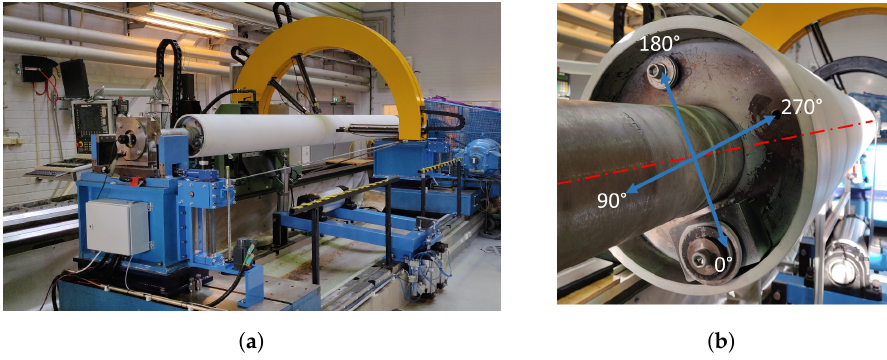
Figure 2. The final test setup. ( a ) The reflective laser sensors are attached to the yellow arc ( b ) The unbalance masses and the balancing masses attached to the Non-Drive End (NDE) end of the tube section. Table 2. Unbalance mass, eccentricity, magnitude and phase in the measured cases.